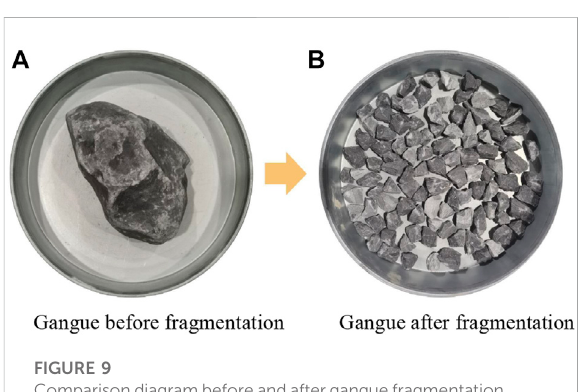
FIGURE 9 Comparison